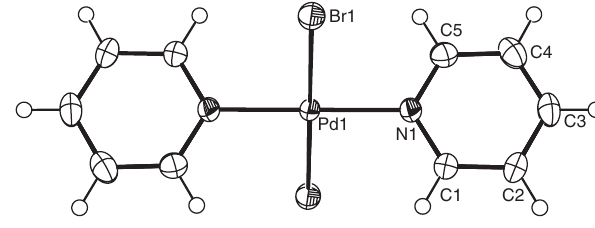
Table 1: Data collection and handling.